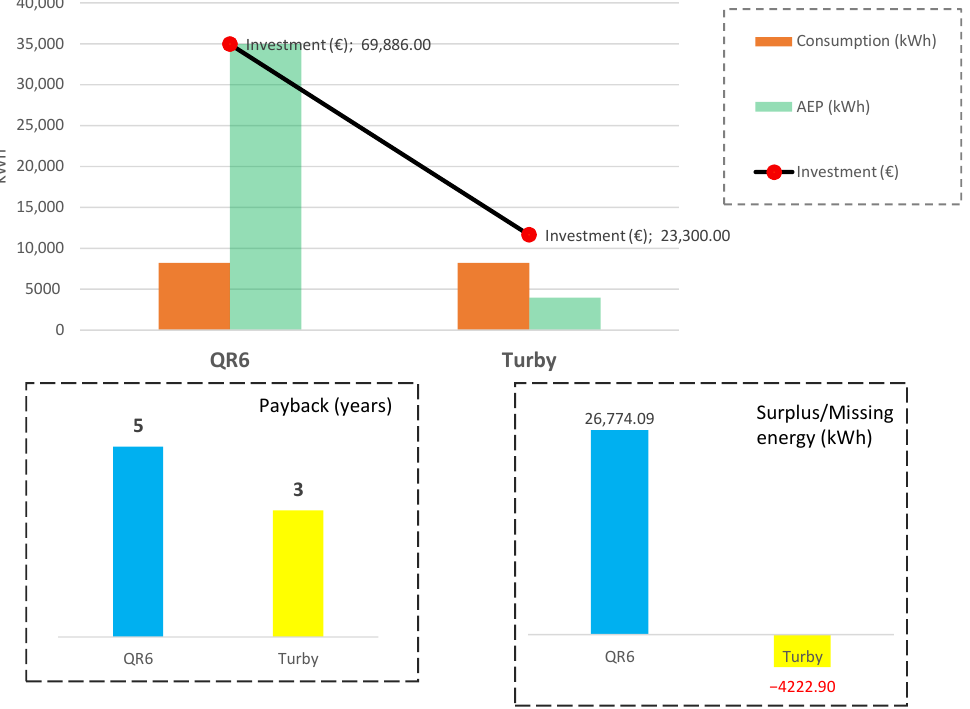
Figure 11. AEP (kWh), investment, payback and surplus/missing energy. Typology: on the roofs of buildings. Authors’ own